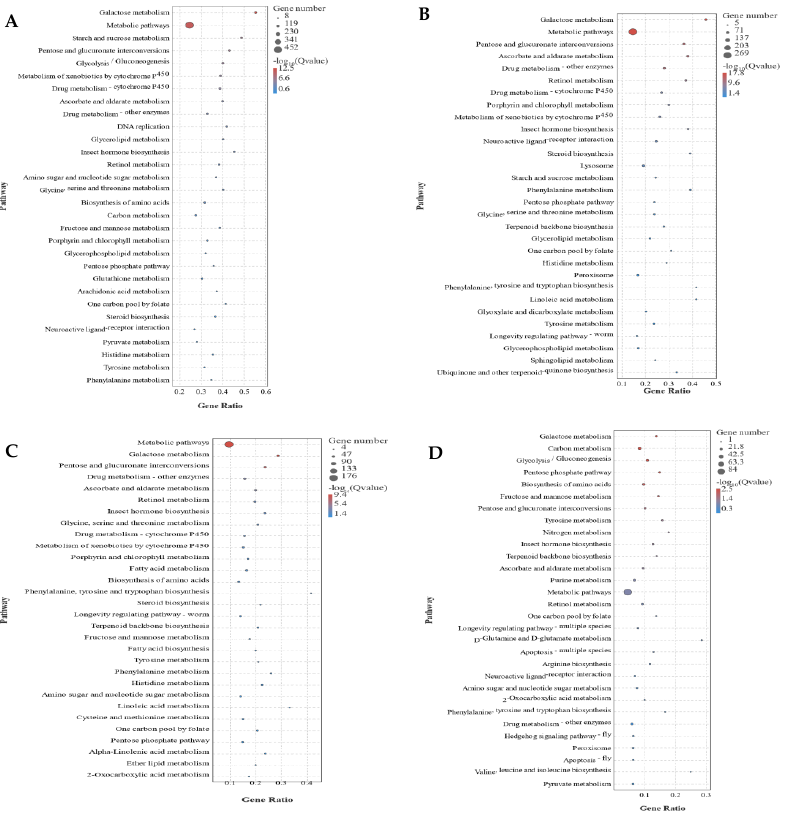
Figure 5. KEGG enrichment analysis of differentially expressed genes CK (control) vs. 1d ( A ), CK vs. 3d ( B ), CK vs. 5d ( C ), and CK vs. 7d ( D ).